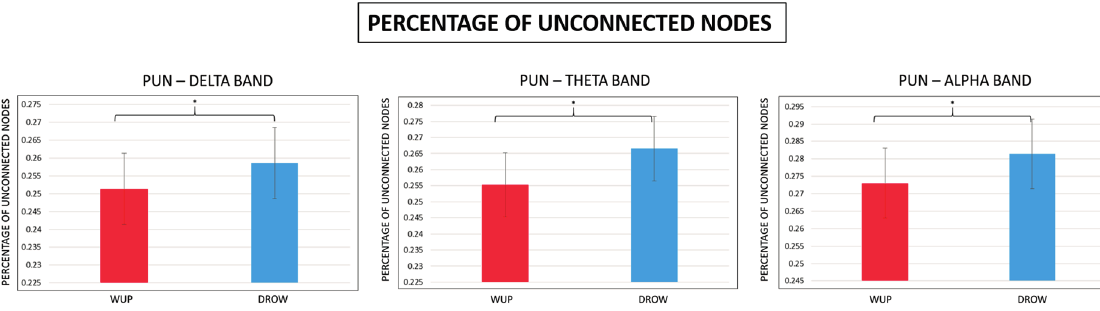
Figure 9. Mean Percentage of Unconnected Nodes (PUN) values in the delta, theta and